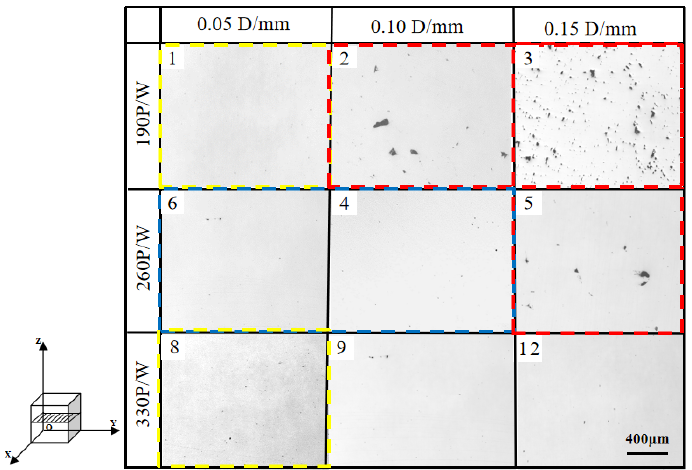
Figure 7. Porosity distribution of 316 L stainless steel samples fabricated via LPBF at various laser powers and scan speeds.